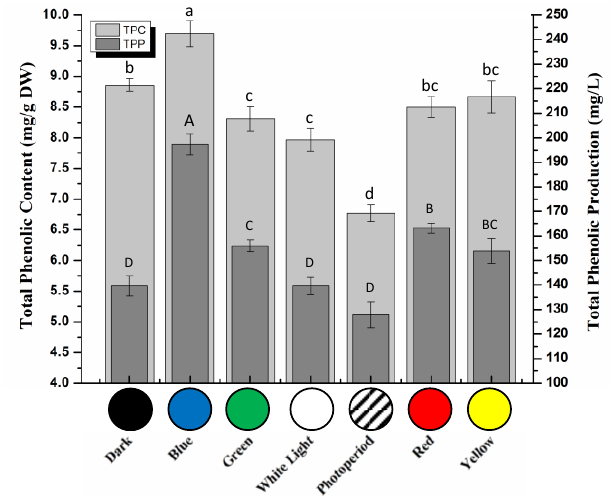
Figure 4. Total phenolic content (TPC) and total phenolic production (TPP) in callus cultures of S. xanthocarpum grown under different monochromatic lights conditions after 35 days of cultivation. Data are expressed as mean ± SD of at least three independent experiments. Different letters indicate significant differences between conditions ( P < 0.05).